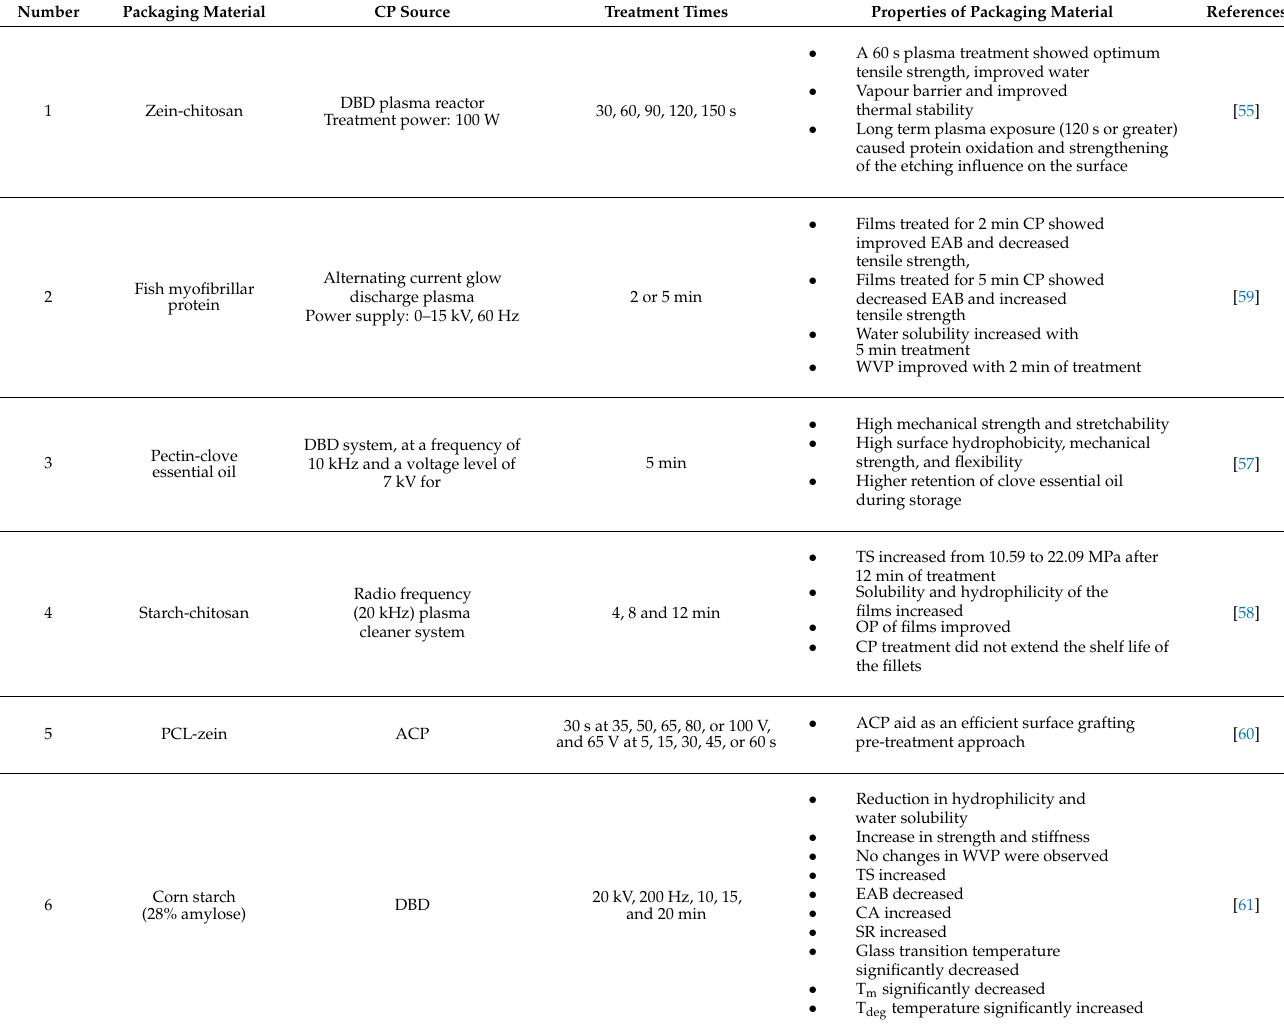
Table 3. Application of CP on biopolymer based packaging